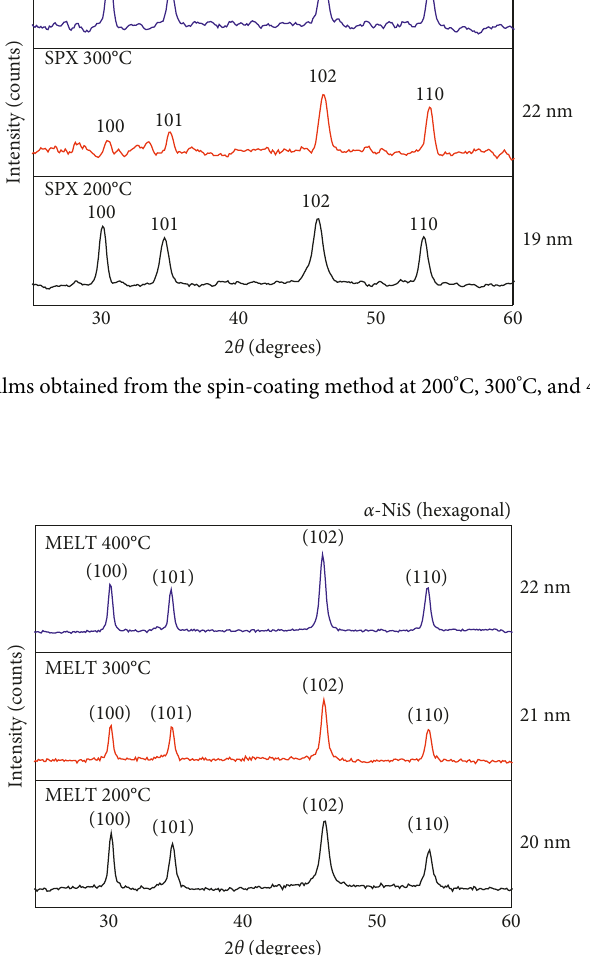
Figure 7: XRD patterns of NiS nanocrystals obtained from the solventless method at 200 ° C, 300 ° C, and 400 ° C (crystallite sizes are shown on the